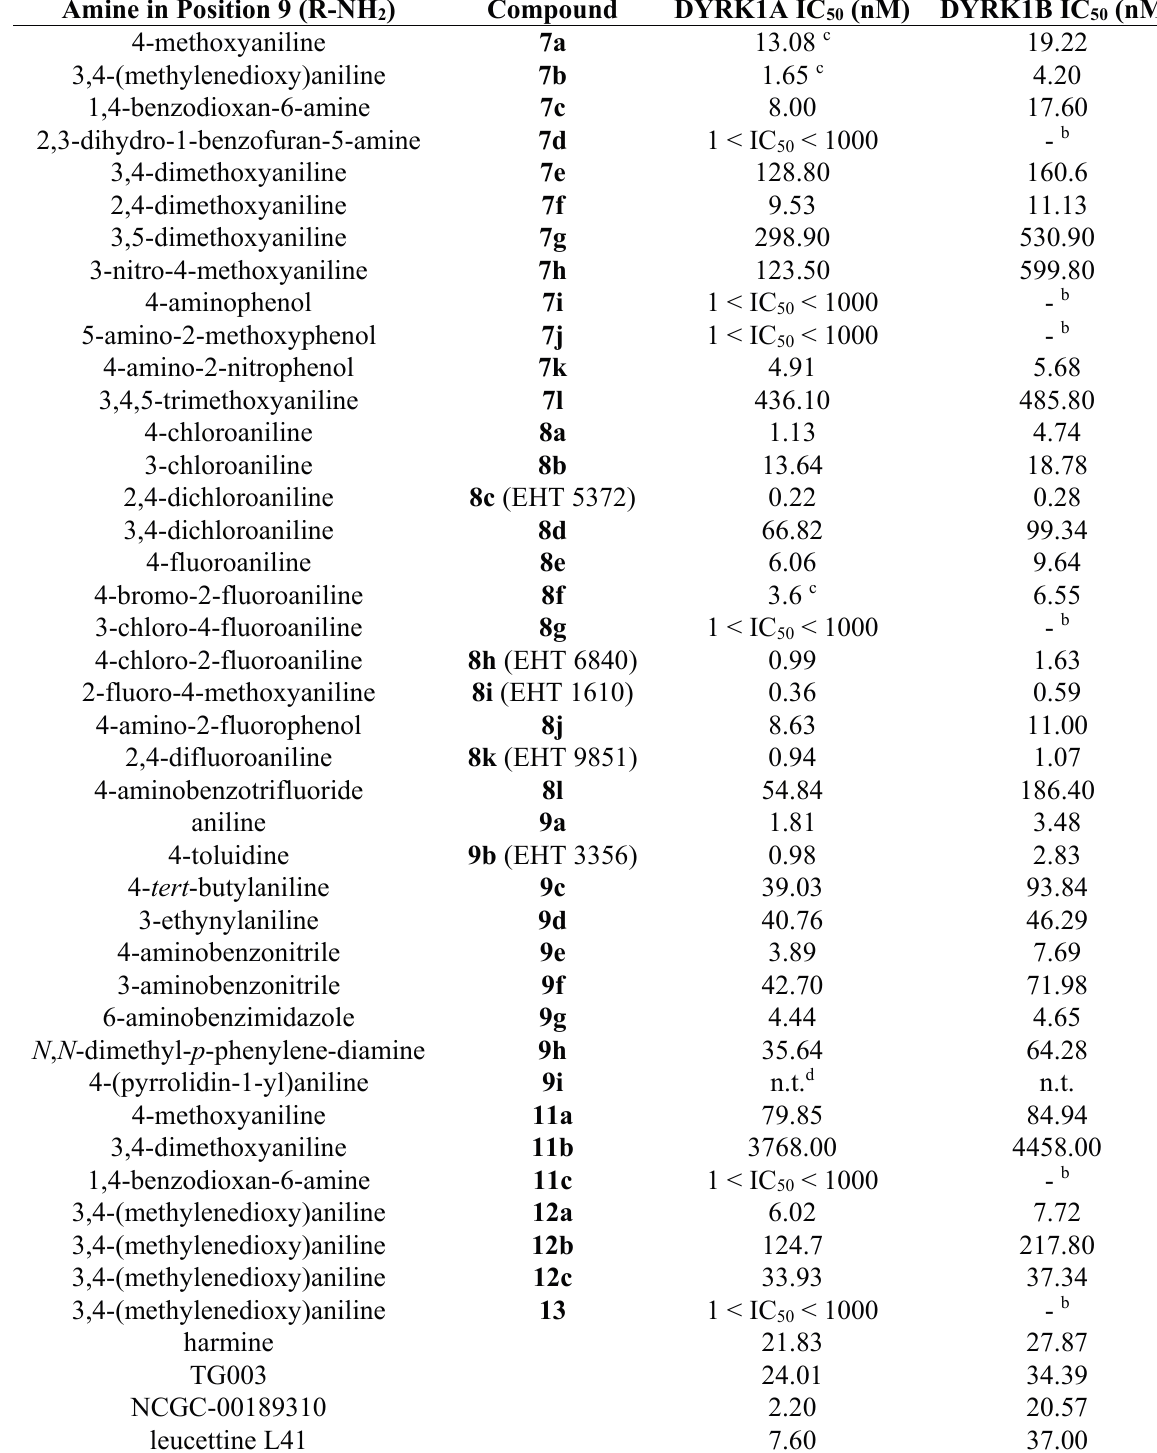
Table 2. DYRK1A and DYRK1B kinase inhibitory activity a of the four methyl thiazolo[5,4- f ]quinazoline carbimidate series ( 7 , 8 , 9 , and 11 ); ethyl, isopropyl and benzyl carbimidates ( 12a – c ) and methyl carboxylate ( 13